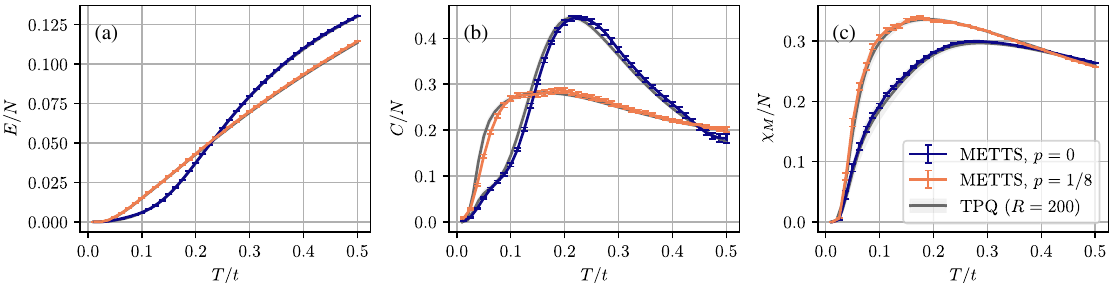
FIG. 12. Comparison ofthermodynamics fromMETTSwithTPQona 4 × 4 cylinderforholedopings p ¼ 0 and p ¼ 1 = 8 .ForTPQ,we use R ¼ 200 random vectors to obtain the statistical error indicated by the error tubes. (a) Internal energy E ¼ h H i as a function of the temperature. (b) Specific heat C ¼ dE=dT obtained from numerical differentiation of the energy. We apply a Tikhonovregularization with α ¼ 0 . 1 to compute the derivative. (c) Magnetic susceptibility χ ε ¼ 10 − 6 and a m . We find agreement within error bars. We use a cutoff of 2000 for imaginary-time evolution in maximum bond dimension D max ¼